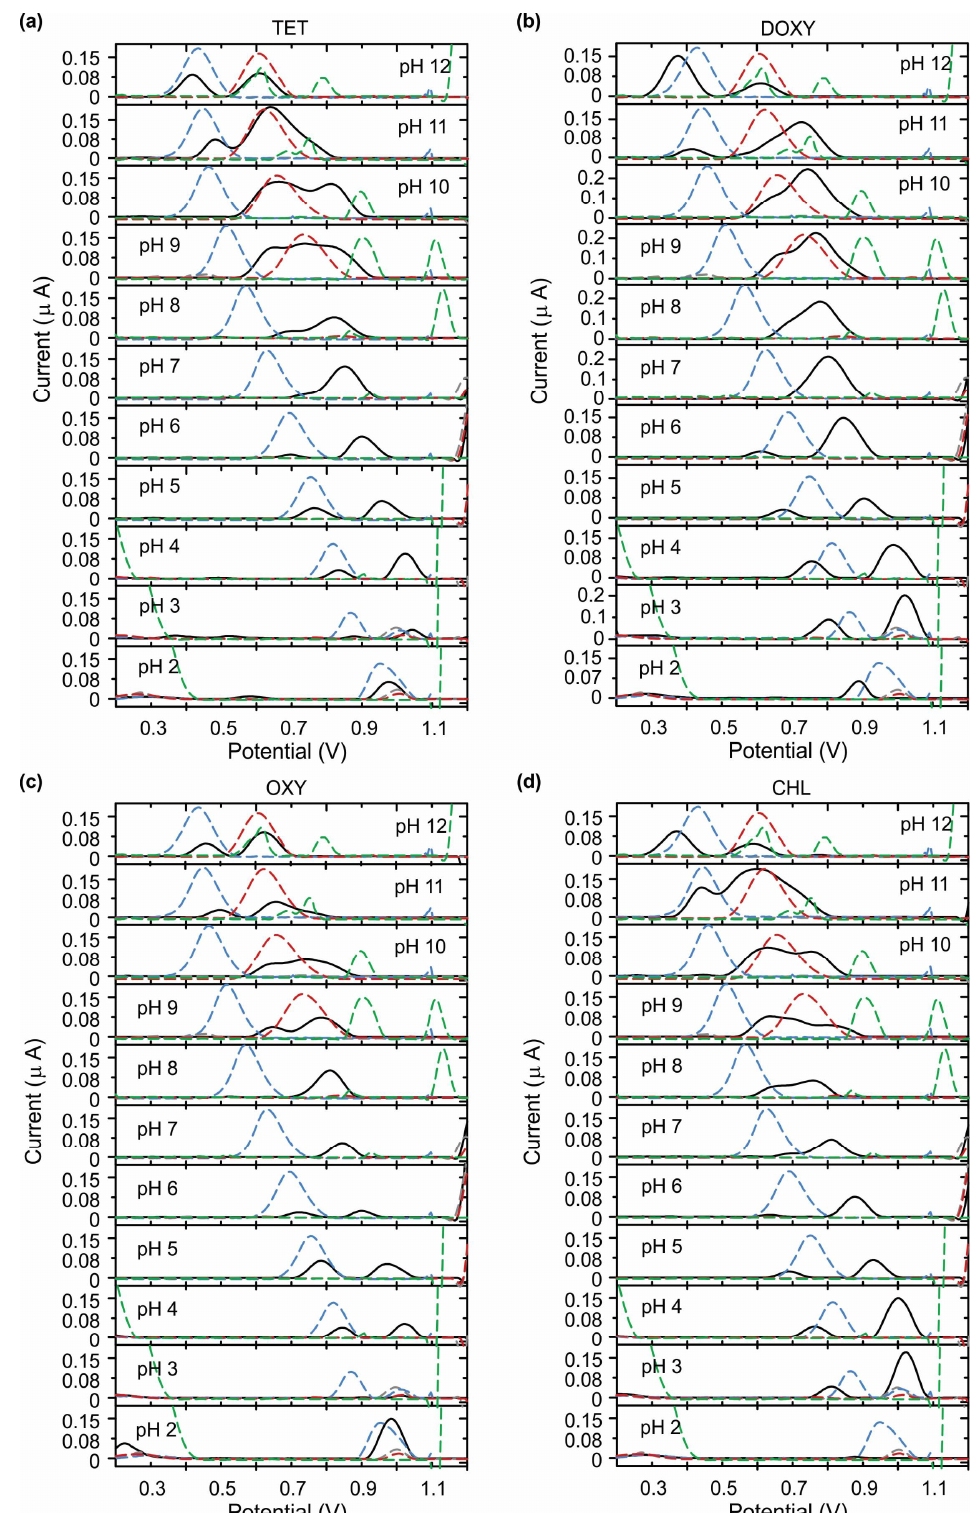
Figure 2. Square wave voltammograms (baseline-corrected) obtained in the whole pH screening range (2–12) using Britton Robinson buffer of all TCs (black line) ( a ) TET, ( b ) DOXY, ( c ) OXY, and ( d ) CHL at 10 µM concentration each. Phenol (blue dashed line), benz[b]anthracene (grey dashed line), and N,N-dimethylcyclohexylamine (red dashed line) in a concentration of 10 µM, and 6,11-dihydroxy-5,12-naphthacenedione (green dashed line) in a concentration of 1 mM.